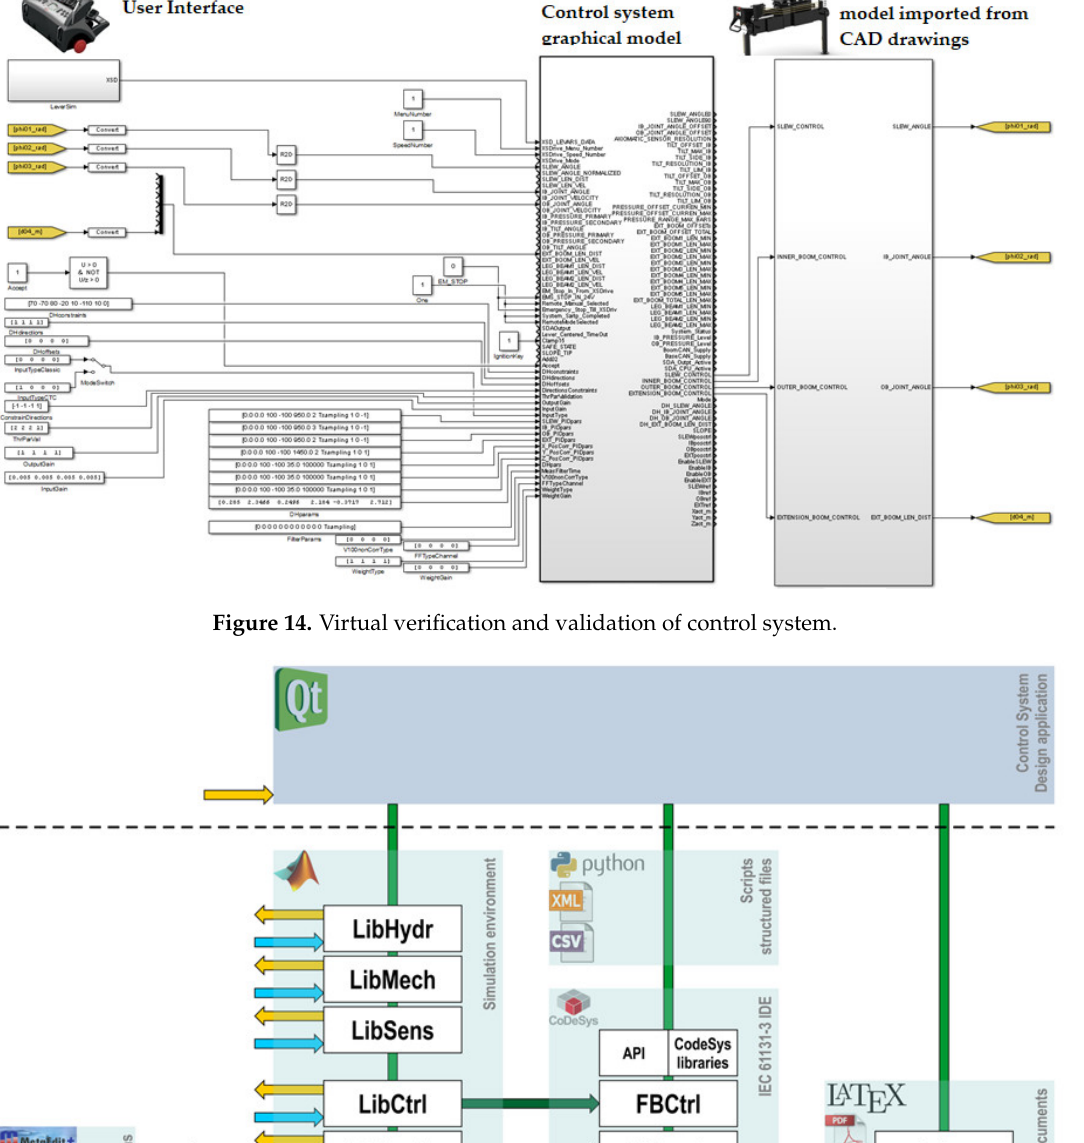
20 of 40 Figure 13. HIAB example crane (http://hidrauline-kelimo-technika.enax.lt/hiab-xs-211-pro/). Normally, such operation is conducted by controlling separate cylinders (SLEW_CONTROL, INNER_BOOM_CONTROL, OUTER_BOOM_CONTROL, EXTENSION_BOOM_CONTROL). Resulting CRANE_TIP – XYZ is normally an output of the system. The proposed approach was to